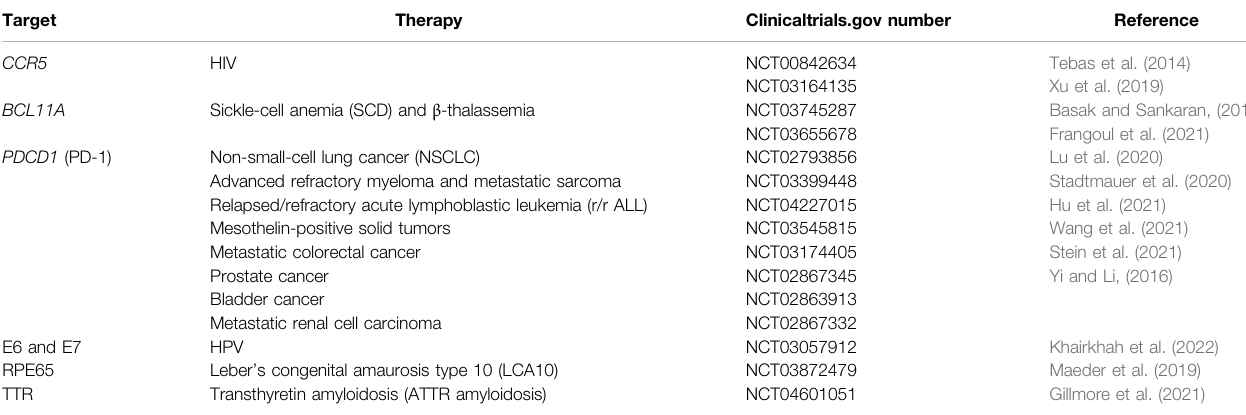
TABLE 2 | Clinical trials of the CRISPR/Cas9